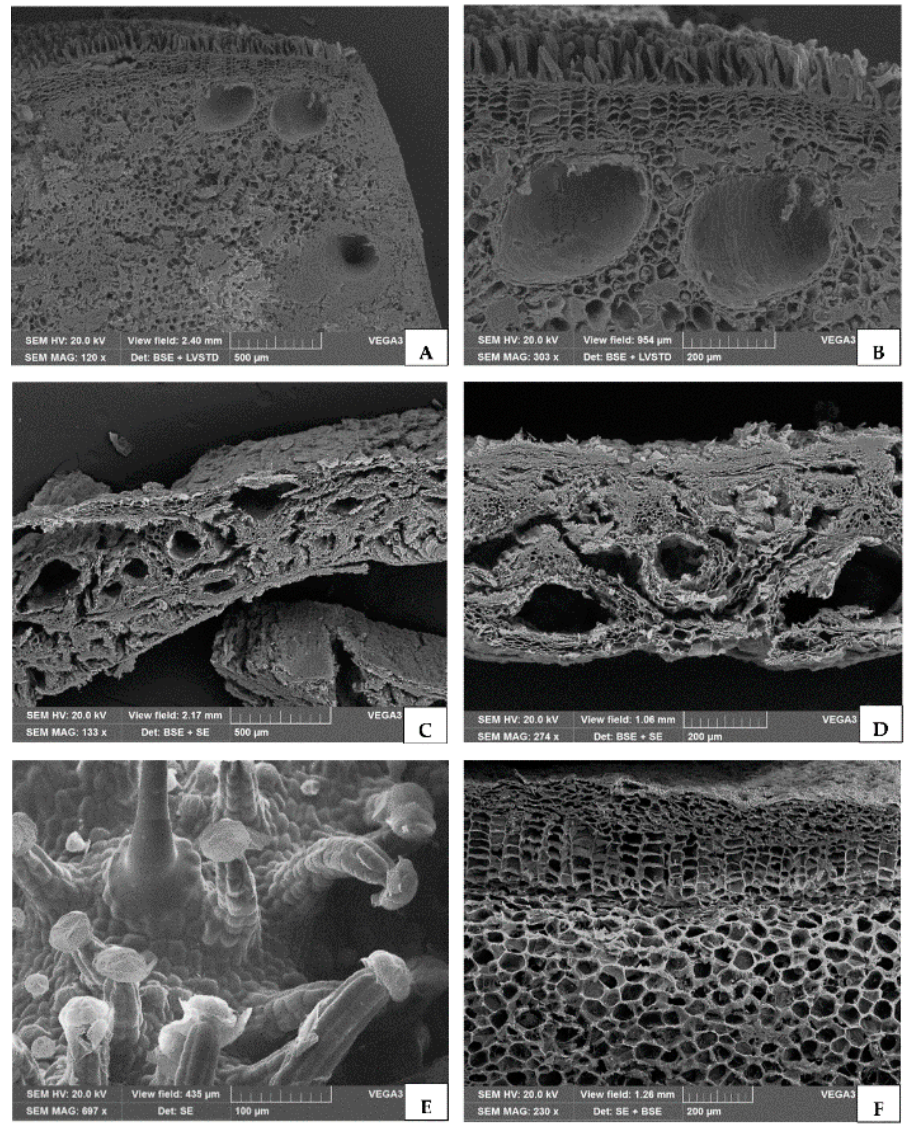
Figure 1. SEM micrographs of di ff erent plant tissues used for EO isolation. ( A , B ) Cross section of a cone scale from Cupressus sempervirens L., showing several resin ducts at di ff erent magnifications. ( C , D ) Particular of the cross section of the mesocarp from the Pistacia vera L. var. Bronte hull, showing many resin ducts. ( E ) Inflorescences of Cannabis sativa L. var. Futura 75 showing long, multicellular, stalked glandular trichomes with large heads where resin is produced and stored. ( F ) Section of Zingiber o ffi cinale Roscoe rhizome containing oil globules in secretory cells scattered in the